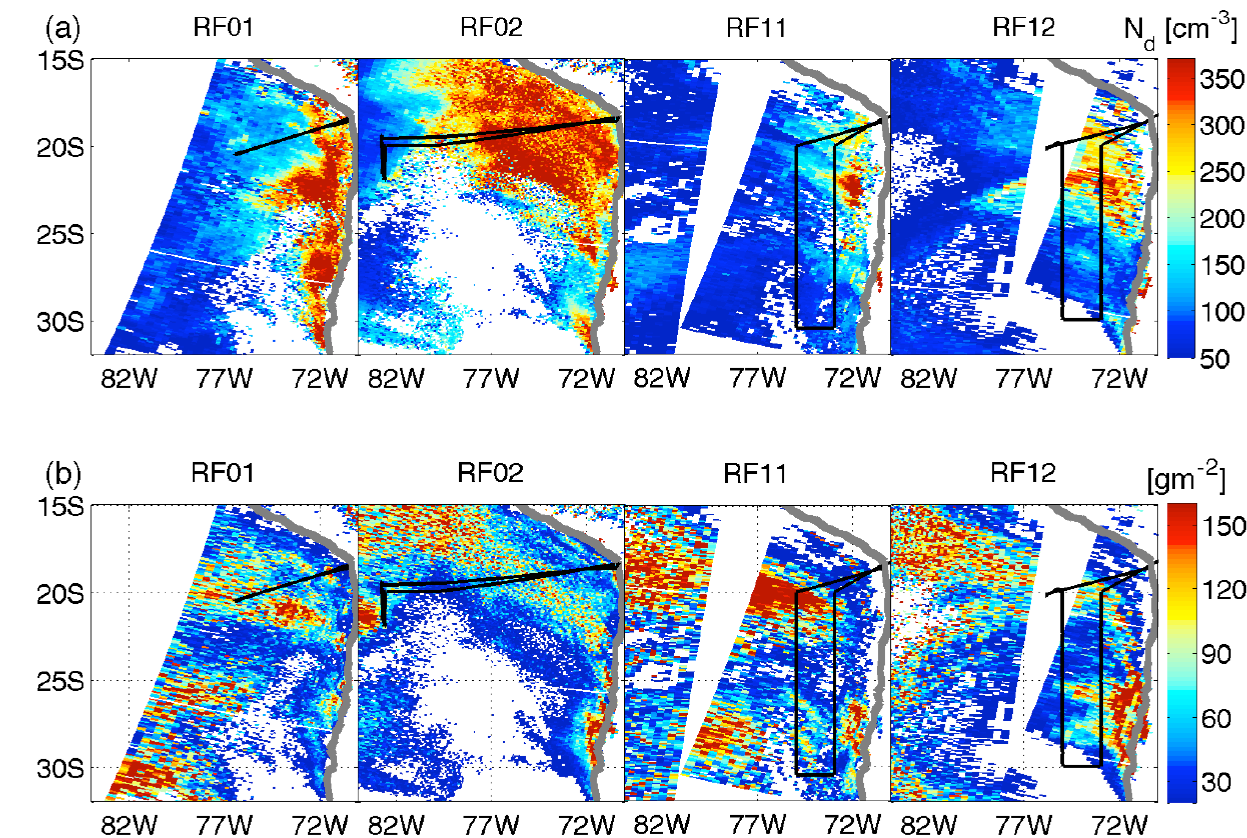
and b) LWP. The black 863 d